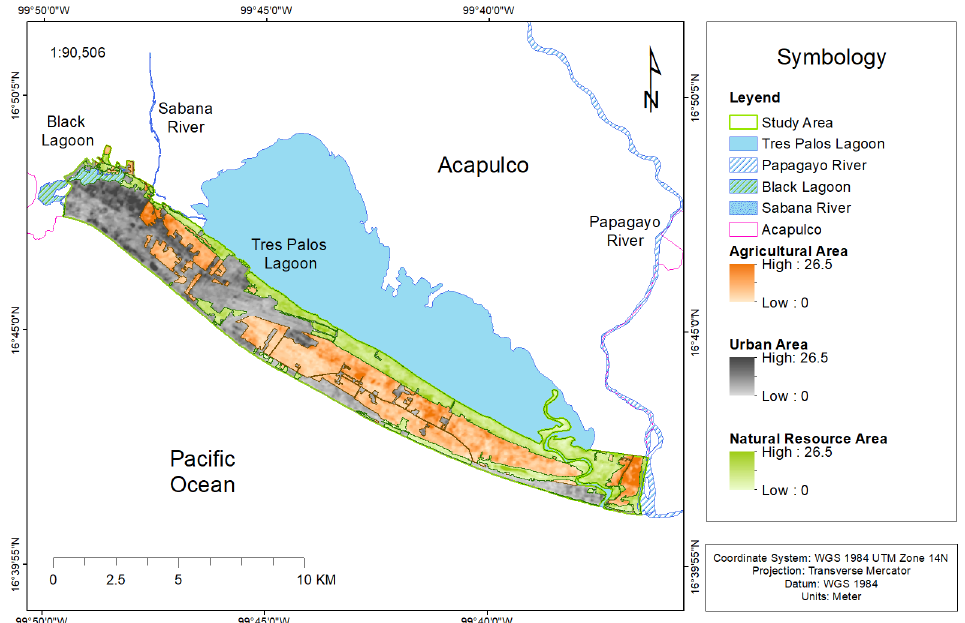
Figure 7. Map showing the types of habitats based on the official land uses in the study area. Identification of the habitat type in the study area: Agricultural Area, Urban Area, and Natural Resource Area. All interior polygons were dissolved, and a mask of the digital elevation model was cut to create three individual rasters.